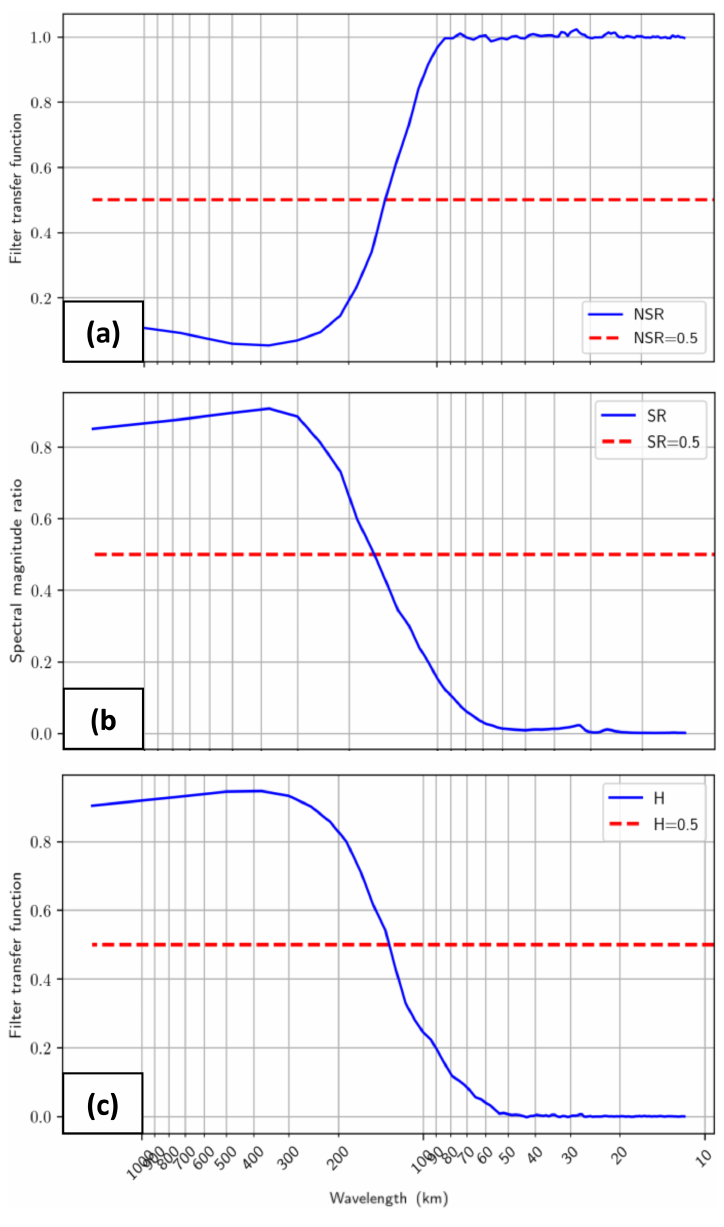
Figure A4. Illustration of the various spectral functions used to estimate the resolution at 45 ◦ N, 330 ◦ E: (a) with NSR method, (b) with SR method and (c) with the transfer function ( H